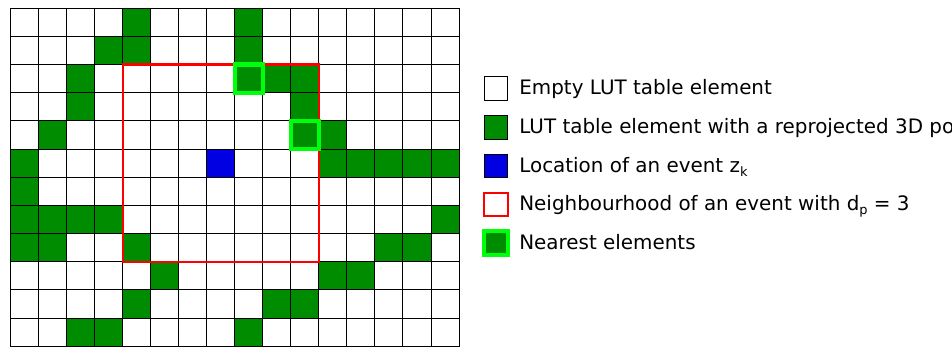
Figure 3. Description of the pixel association process once the LUT is computed. For each event, a search of the closest map element is performed in a given neighborhood. In this example, the LUT-pixel h k to be used for localization will be chosen at random between the two nearest